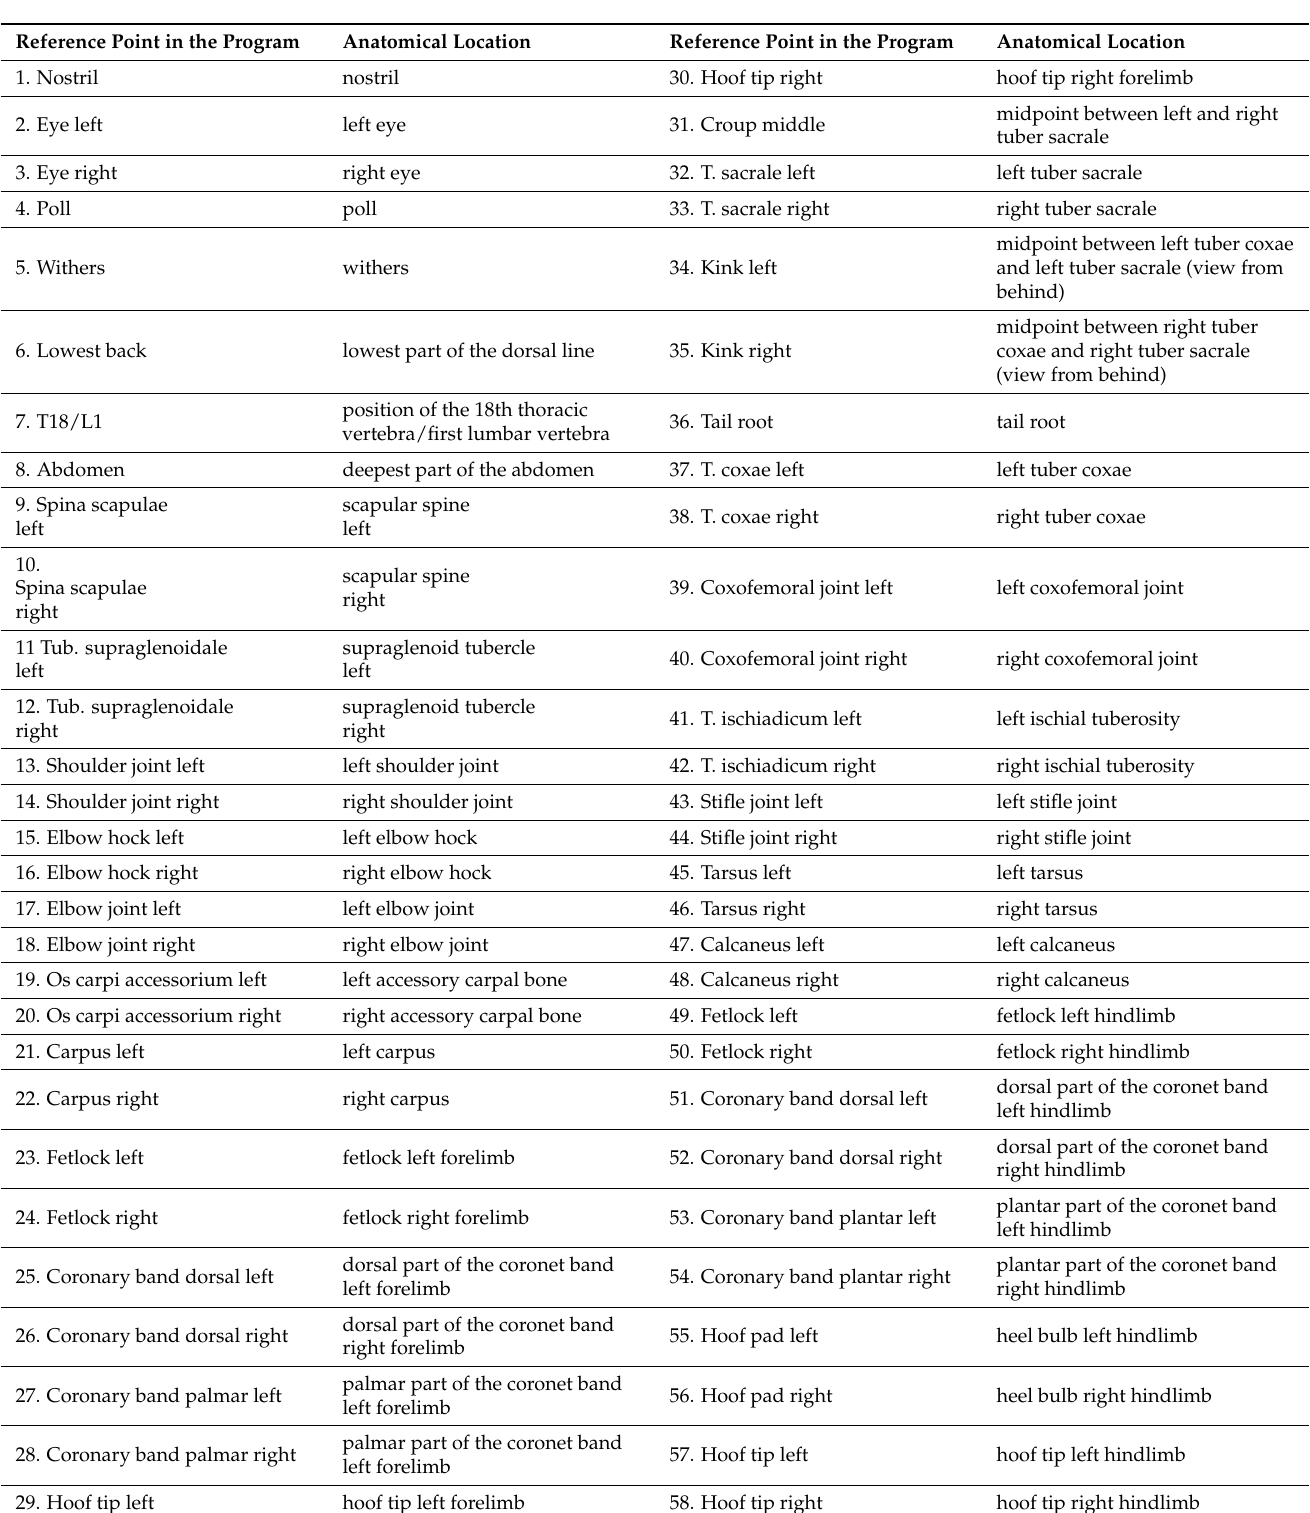
Table A1. Reference points of the program with the correct anatomical